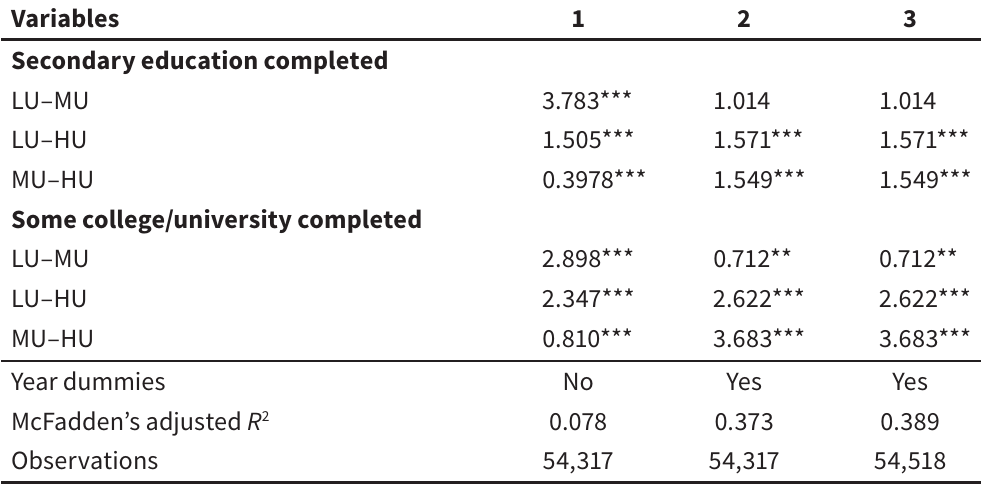
Location choice: destination countries classified by economic